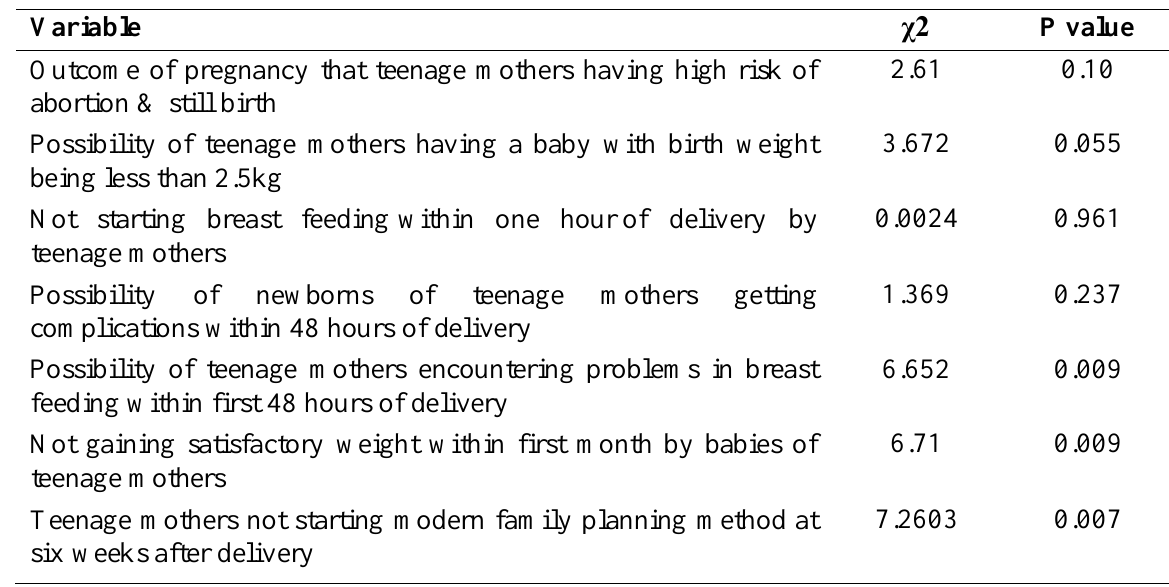
Table 1: Association of pregnancy outcomes between teenage and non-teenage mothers